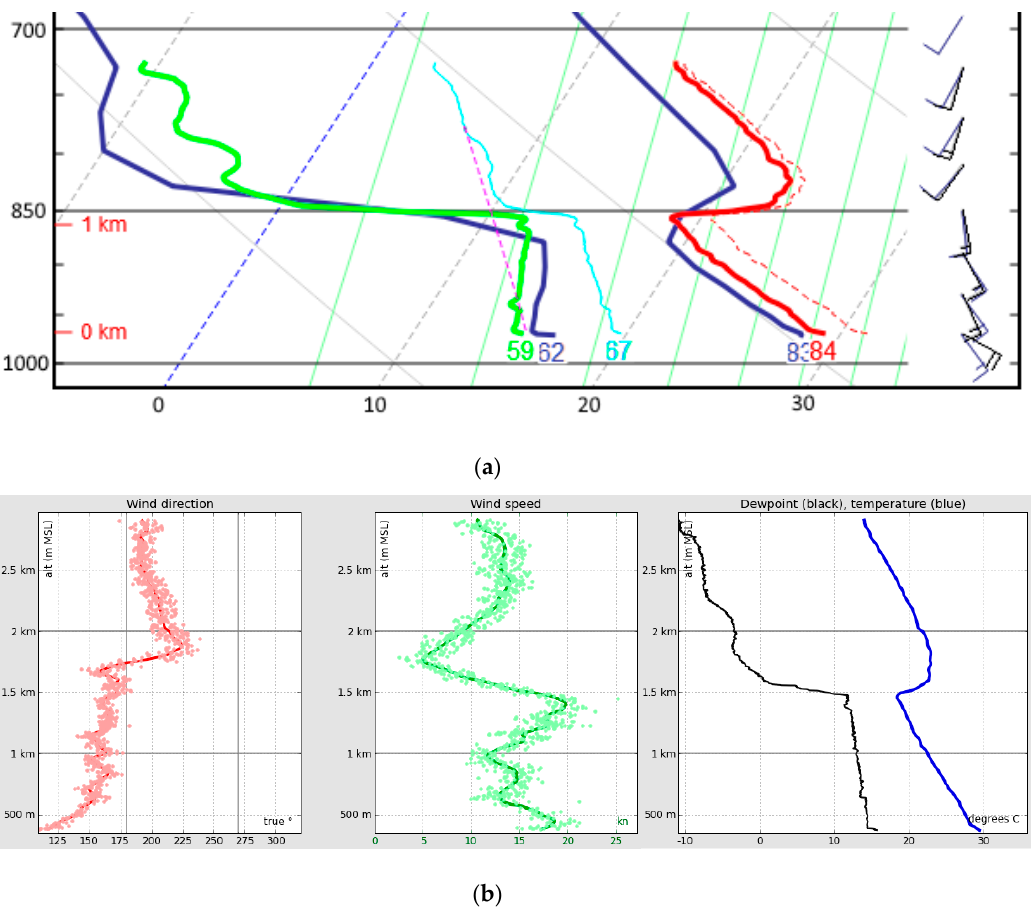
Figure 3. ( a ) Skew-T log-p plot comparing Windsond profile from Amistad Reservoir (101 W) to 2100 UTC HRRR at grid point closest to launch site. Red and green are temperature and dew point from Windsond; blue lines are comparison from HRRR. Windsond winds are in foreground over HRRR winds. Heights are shown AGL, starting from surface elevation of about 350 m MSL. ( b ) Wind, temperature, and dew point profiles at Amistad Reservoir from Windsond software. Heights are shown MSL.